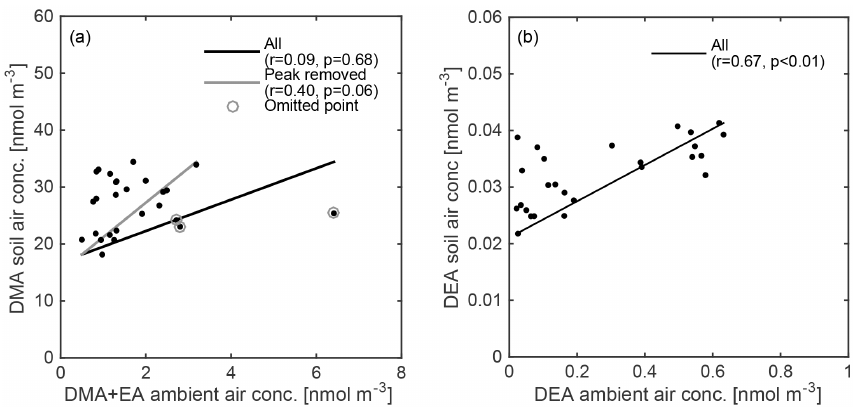
Figure 7. The comparison of measured ambient air concentrations and estimated soil air concentrations of dimethylamine (DMA) and diethylamine (DEA) (panels a and b , respectively) with linear least square fits. In the case of DMA, three data points from autumn have been omitted (see Sect. 3.3), while the least square fits without removed points are shown for